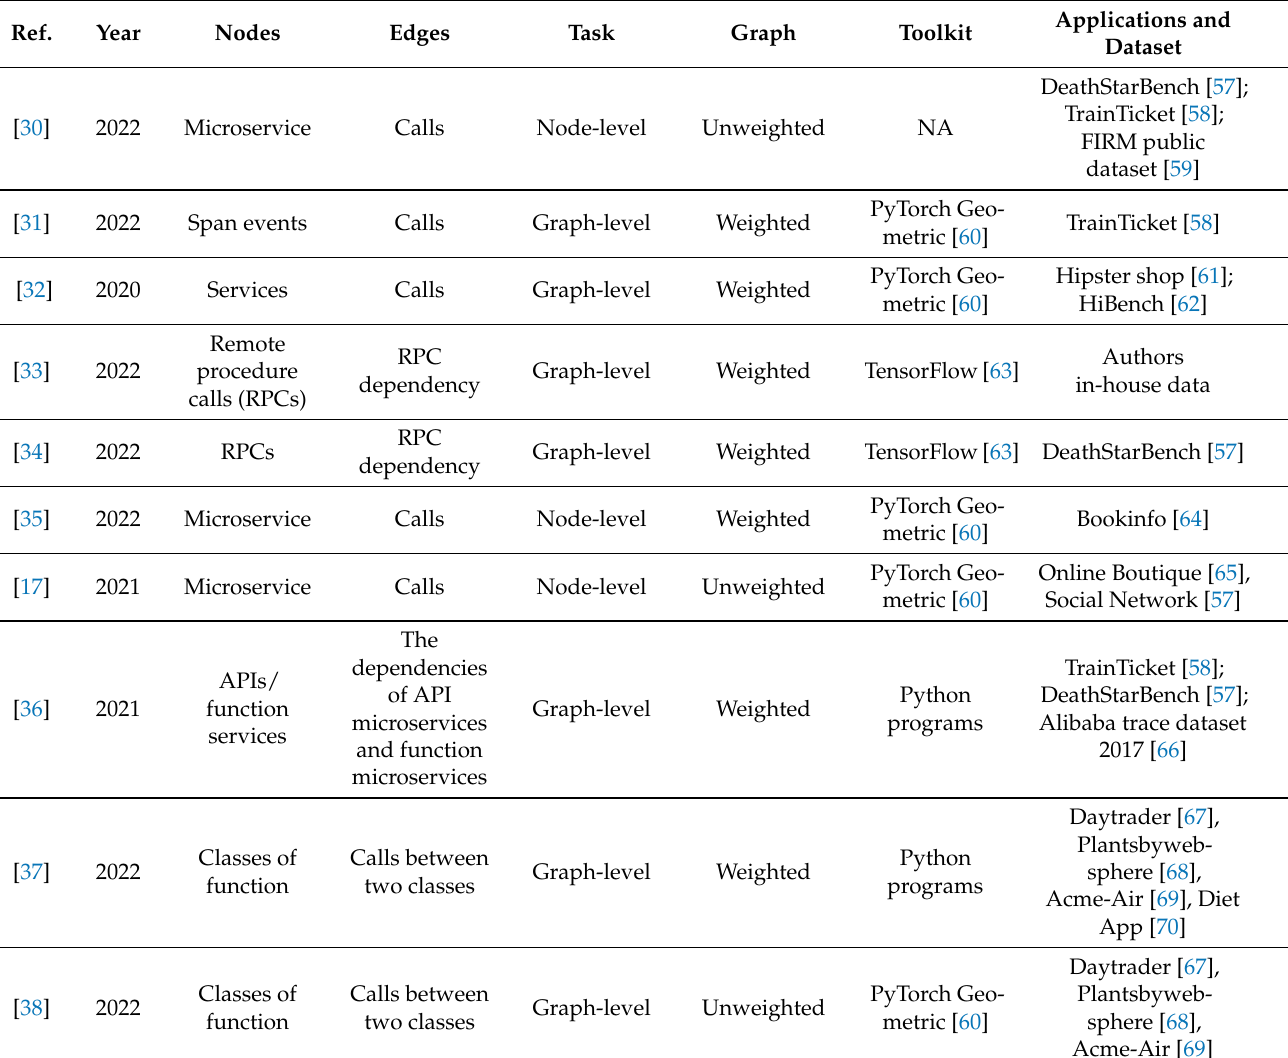
Table 4. Graph structure and